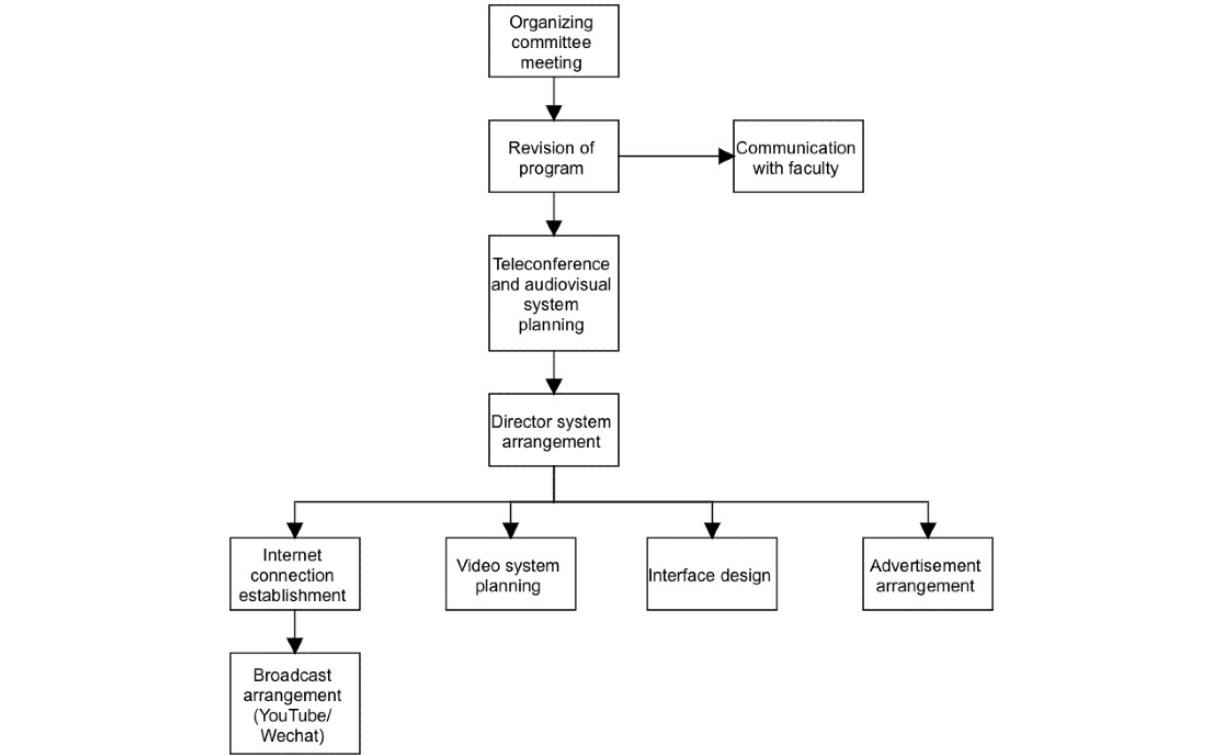
Figure 1. Flowchart of the logistical issues involved in converting an on-site meeting into a web-based